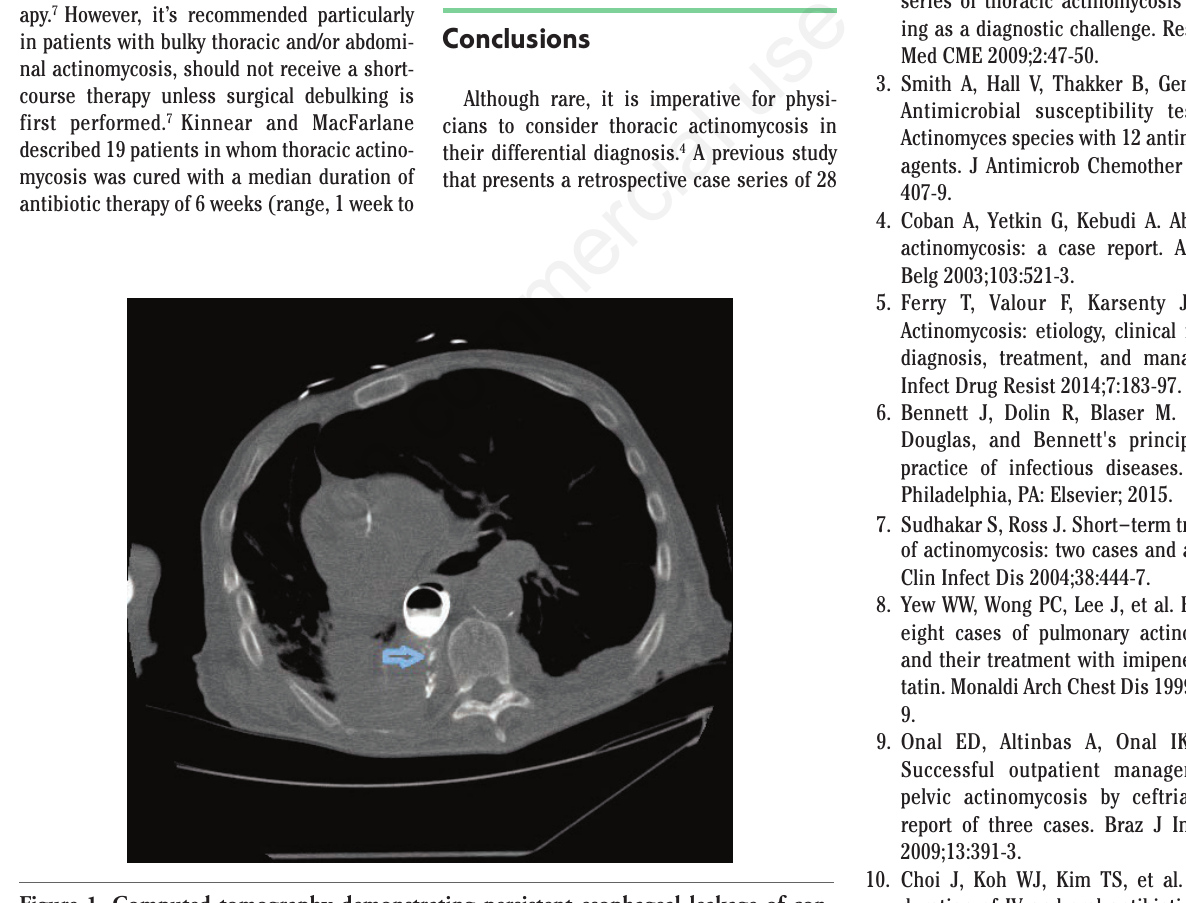
Figure 1. Computed tomography demonstrating persistent esophageal leakage of con- trast from the lower portion of his esophageal stent with filling of the right lobe bronchus, consistent with a bronchopulmonary